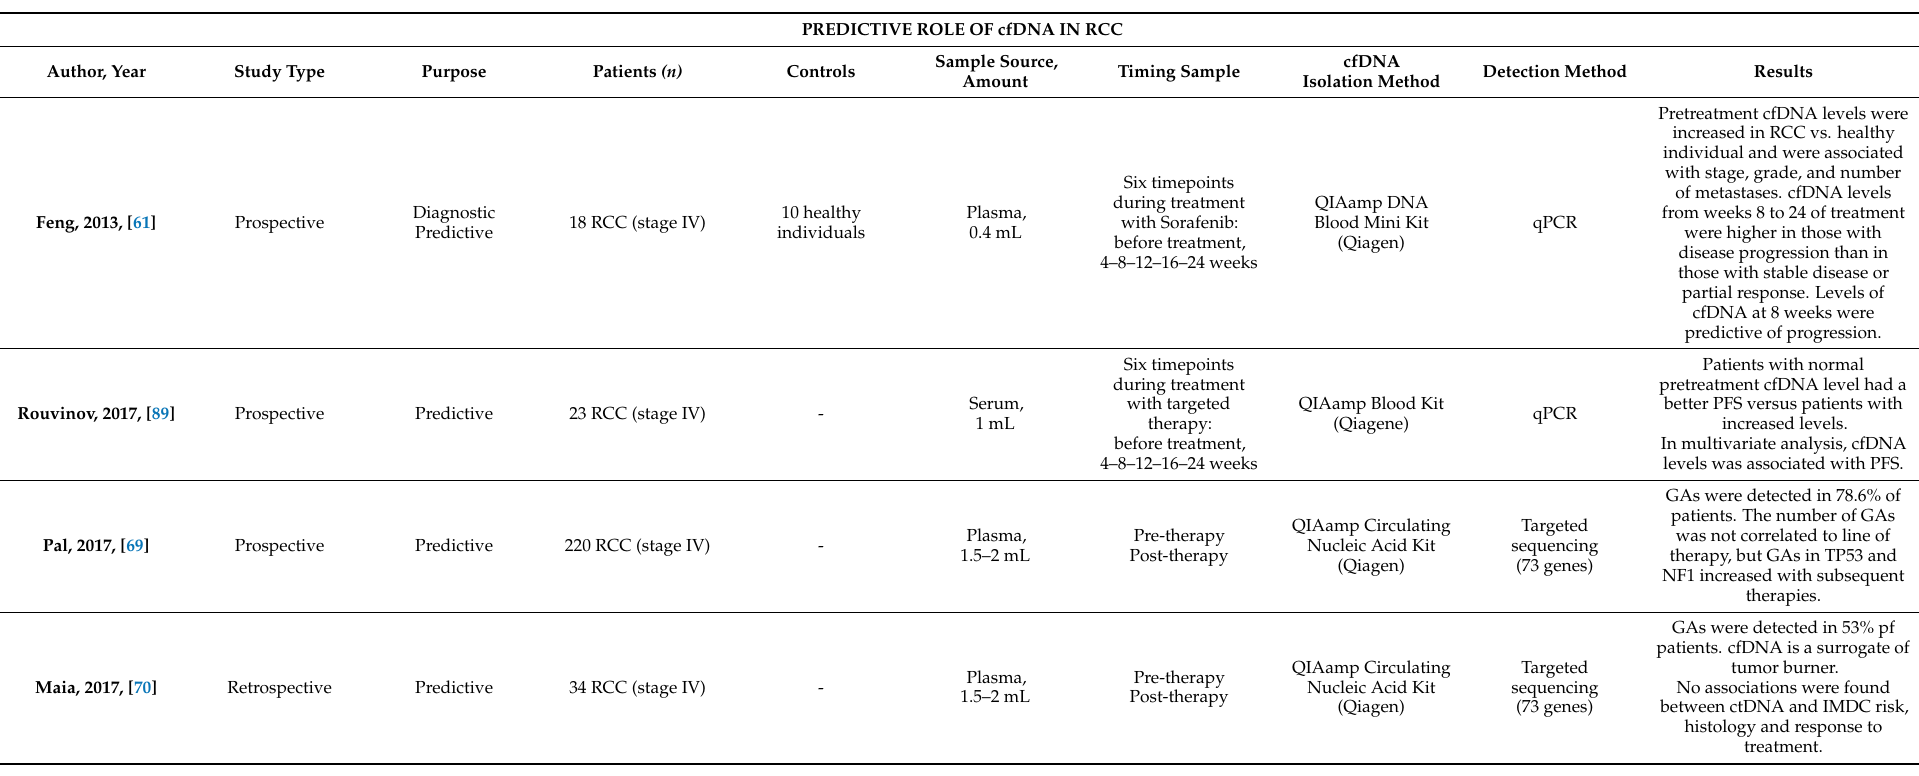
Table 5. Summary of the studies evaluating the predictive role of circulating cell-free DNA (cfDNA) in renal cell carcinoma (RCC). AUC: area Under the Curve; gene: GA: genetic alteration; LOH: loss of heterozygosity; OS: overall survival; PCR: polymerase chain reaction; PFS: progression-free survival; qPCR: real-time polymerase chain